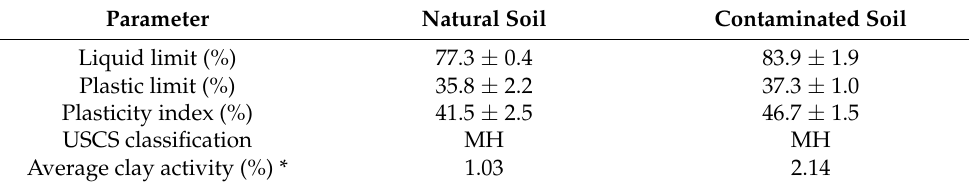
Table 5. Influence of diesel contamination in the consistency limits of